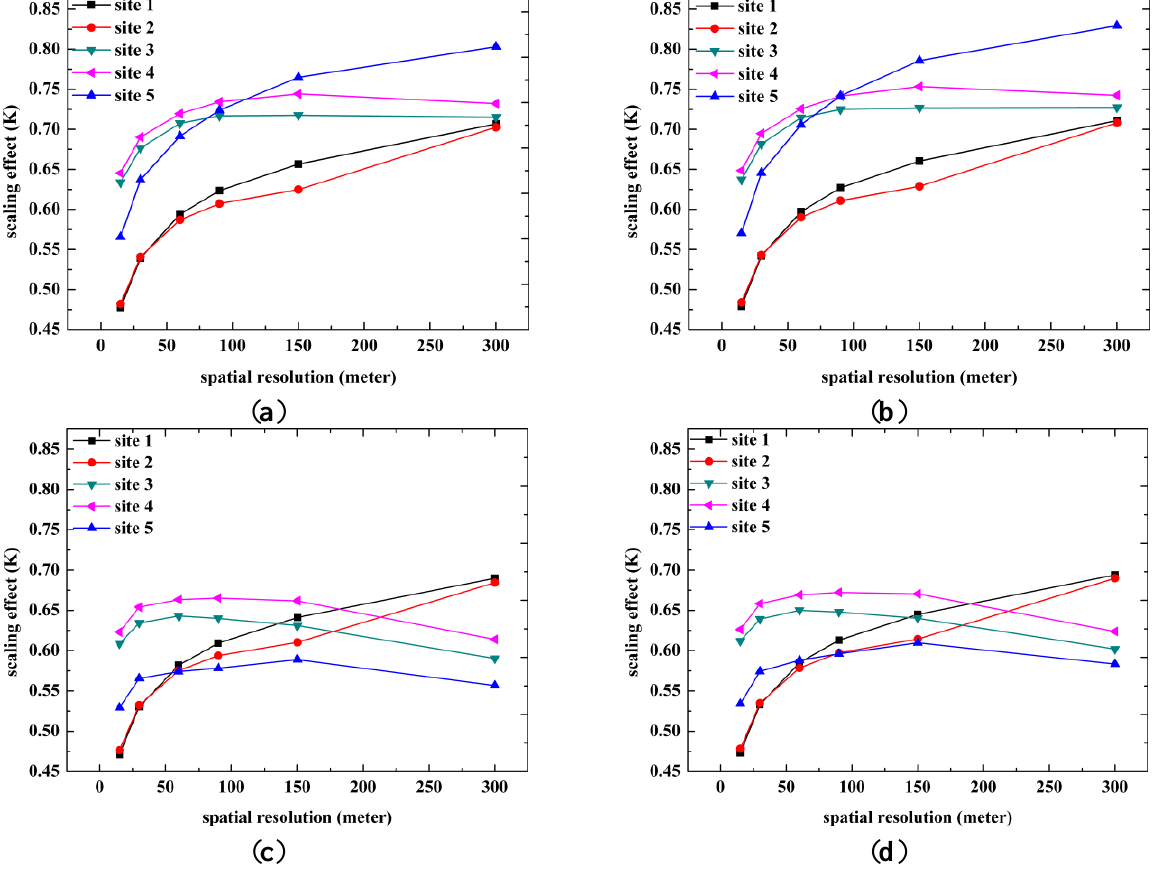
Figure 3. Relationship between the spatial resolution and the LST scaling